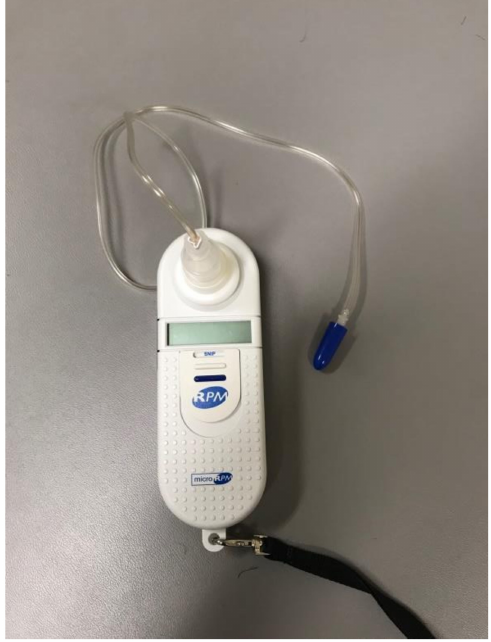
Figure 3. Sniff nasal inspiratory pressure (SNIP)